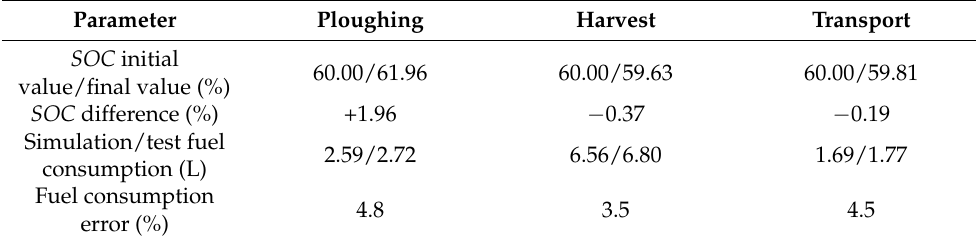
Table 5. Summary of SOC and fuel consumption.